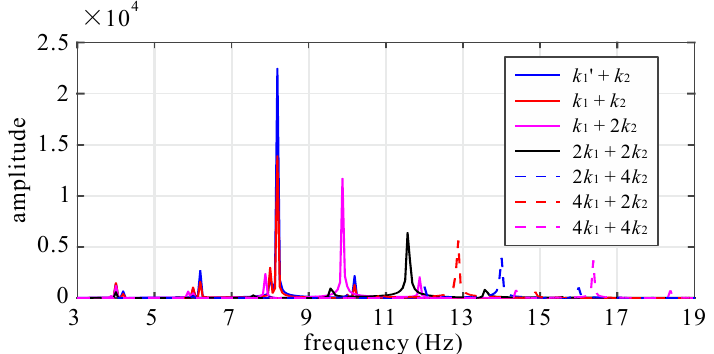
Figure 11. FFT Analysis of φ 3 regarding different stiffness.